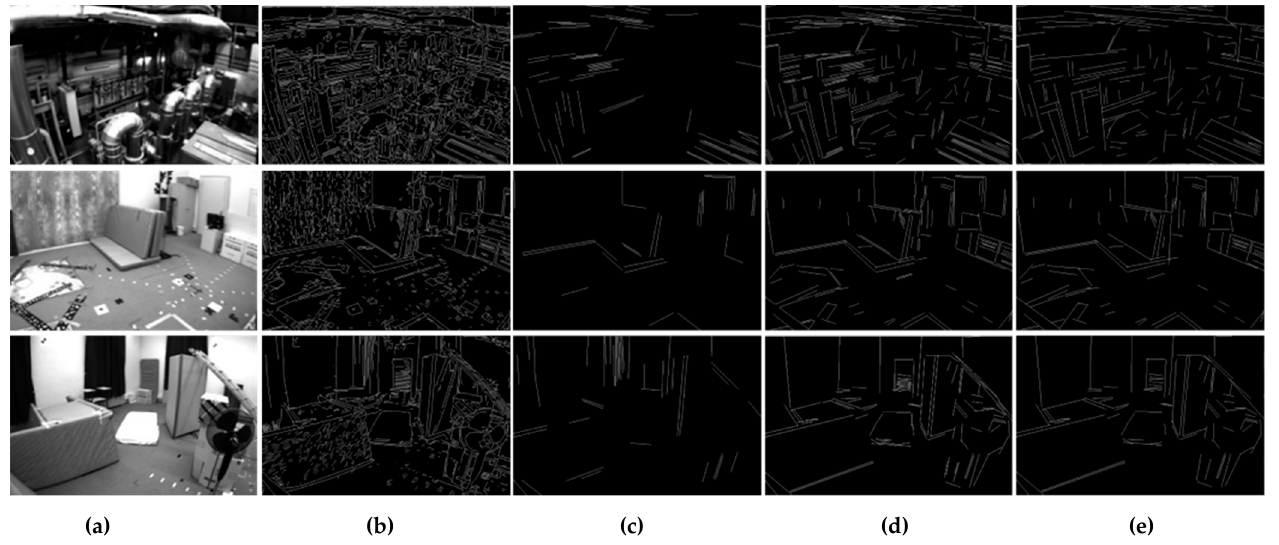
Figure 6. Graph of experimental results: ( a ) three scenarios of EuRoC datasets; ( b ) traditional LSD algorithm; ( c ) LSD algorithm with fixed threshold (line feature extraction algorithm in PL-VINS); ( d ) ours (length filtering); ( e ) ours (length filtering and line segment merging). Table 1. Average line feature extraction quantity and time for different algorithms.